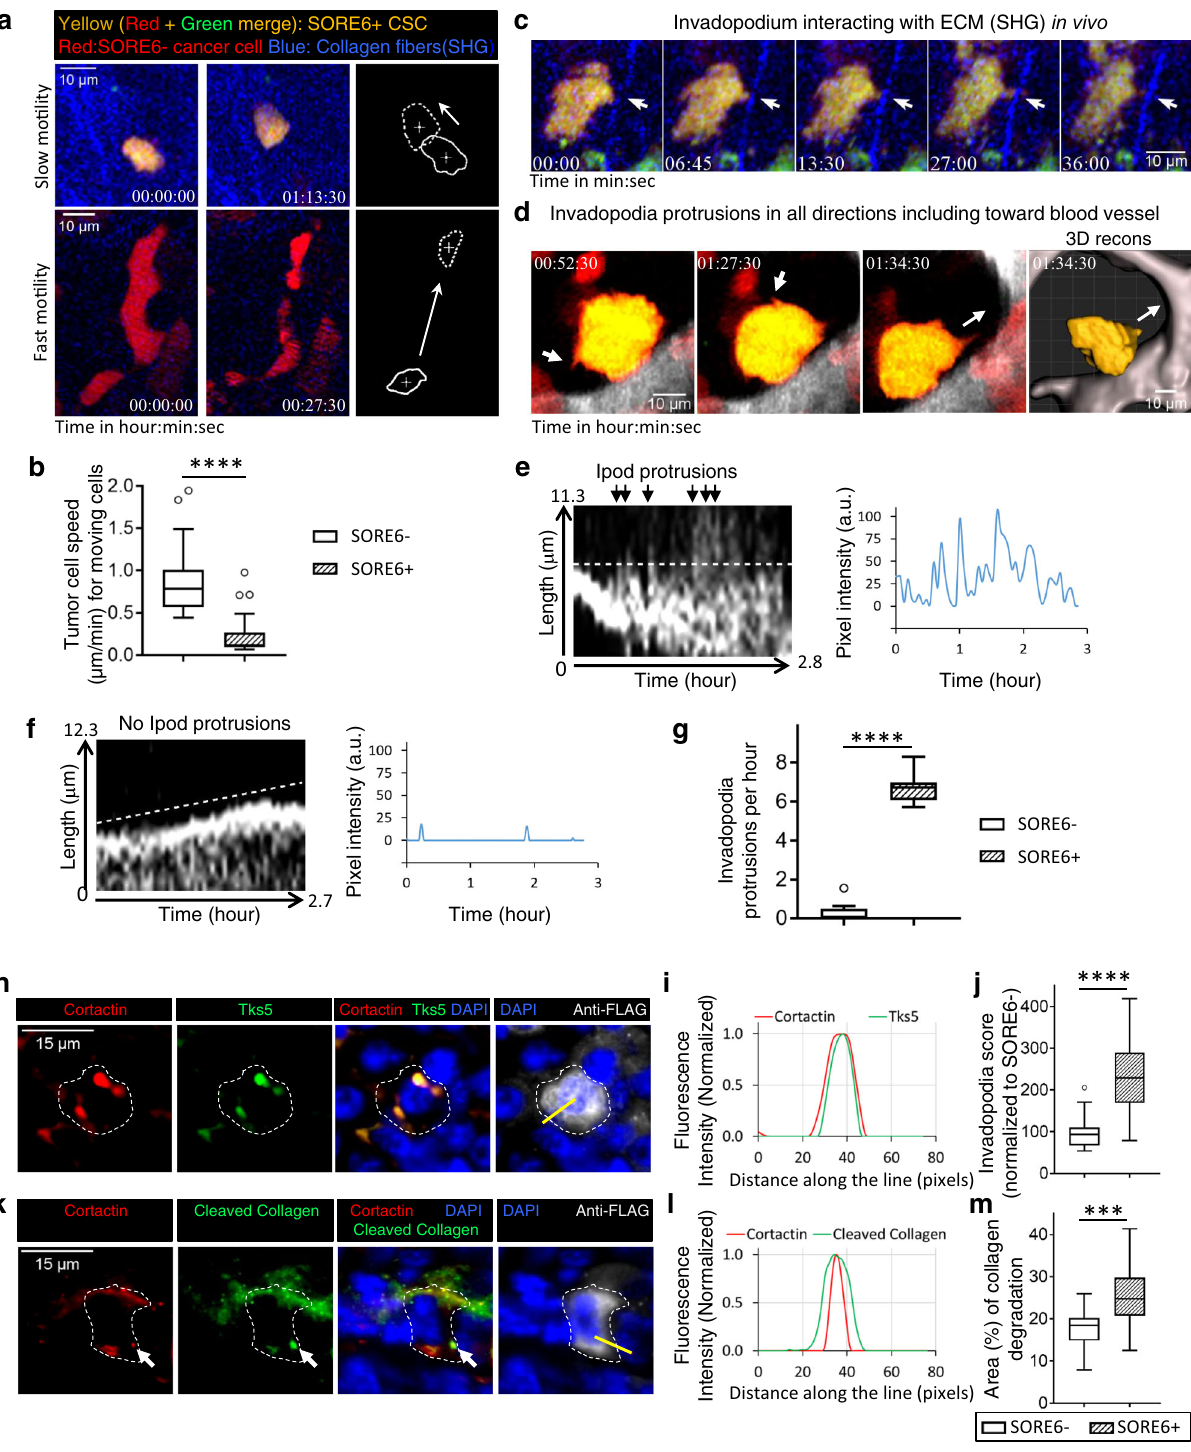
distribution of CSCs and macrophages by intravital imaging of SORE6 + CSCs in primary mammary tumors in mice with (cyan fl uorescent protein (CFP)-expressing macrophages (MacBlue host mice) (Fig. 3a). We found in live tumors that 60 – 70% of the CSCs are in direct physical contact with a macrophage (Fig. 3c). We con fi rmed our fi ndings in fi xed-frozen tumor tissue, more CSCs in direct physical contact with a macrophage than not